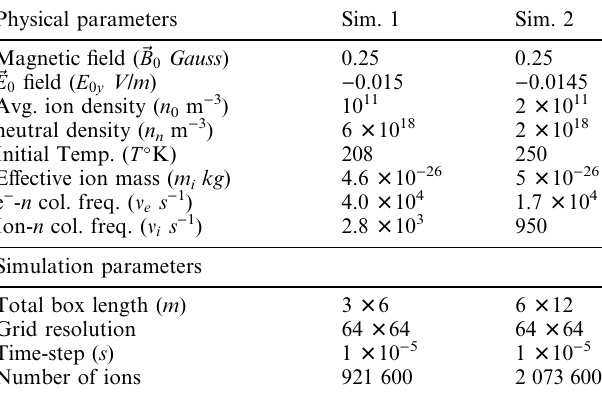
Table 1. Parameters of baseline Farley-Buneman simulation Physical parameters